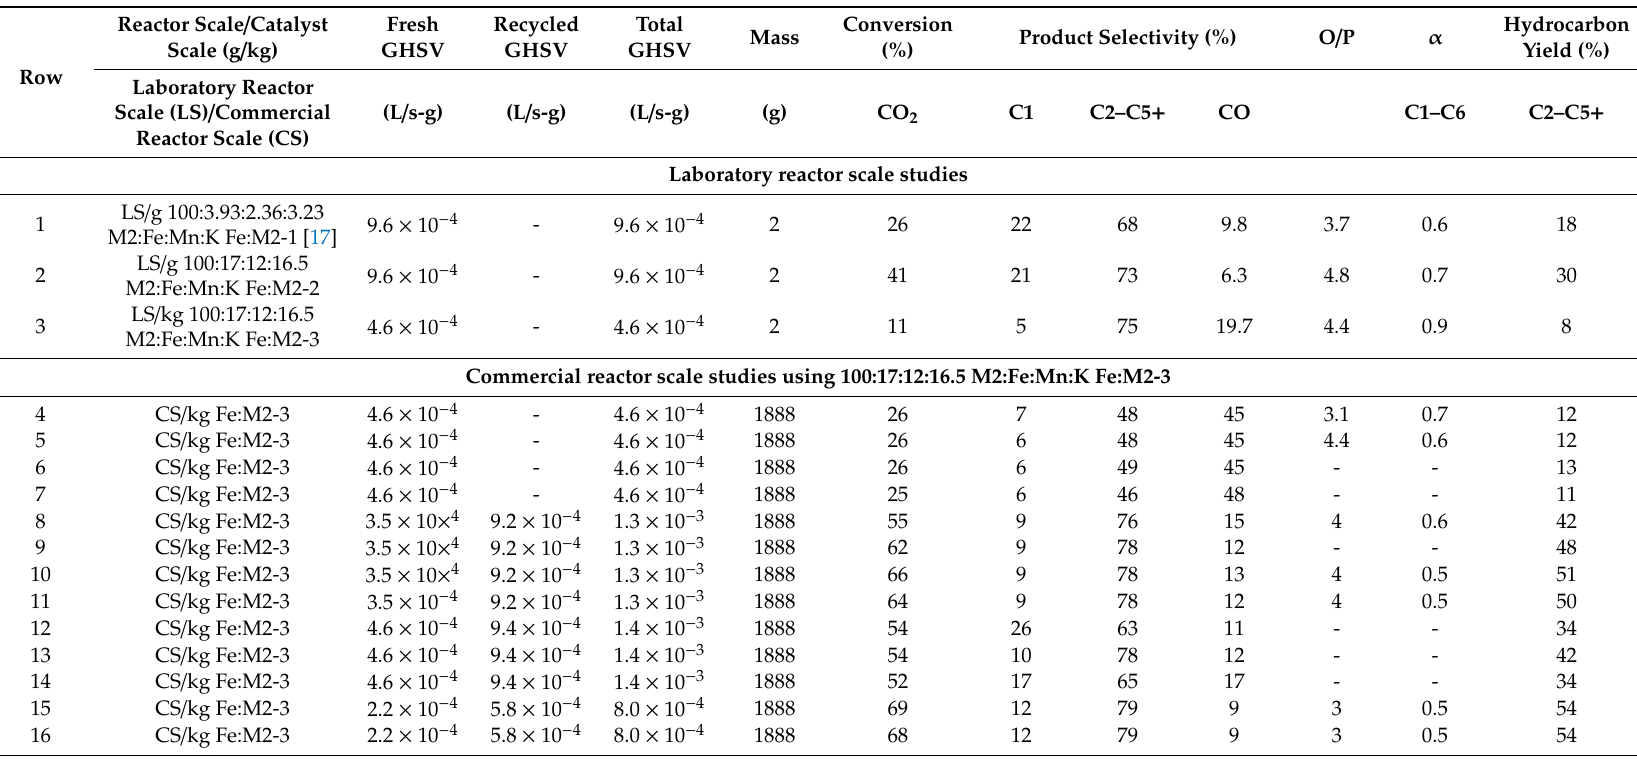
Table 1. Summary of product selectivity, olefin / para ffi n ratio, CO 2 conversion, and ASF values over Fe-based CO 2 hydrogenation catalysts in both laboratory and commercial single-channel scalable modular thermochemical reactor